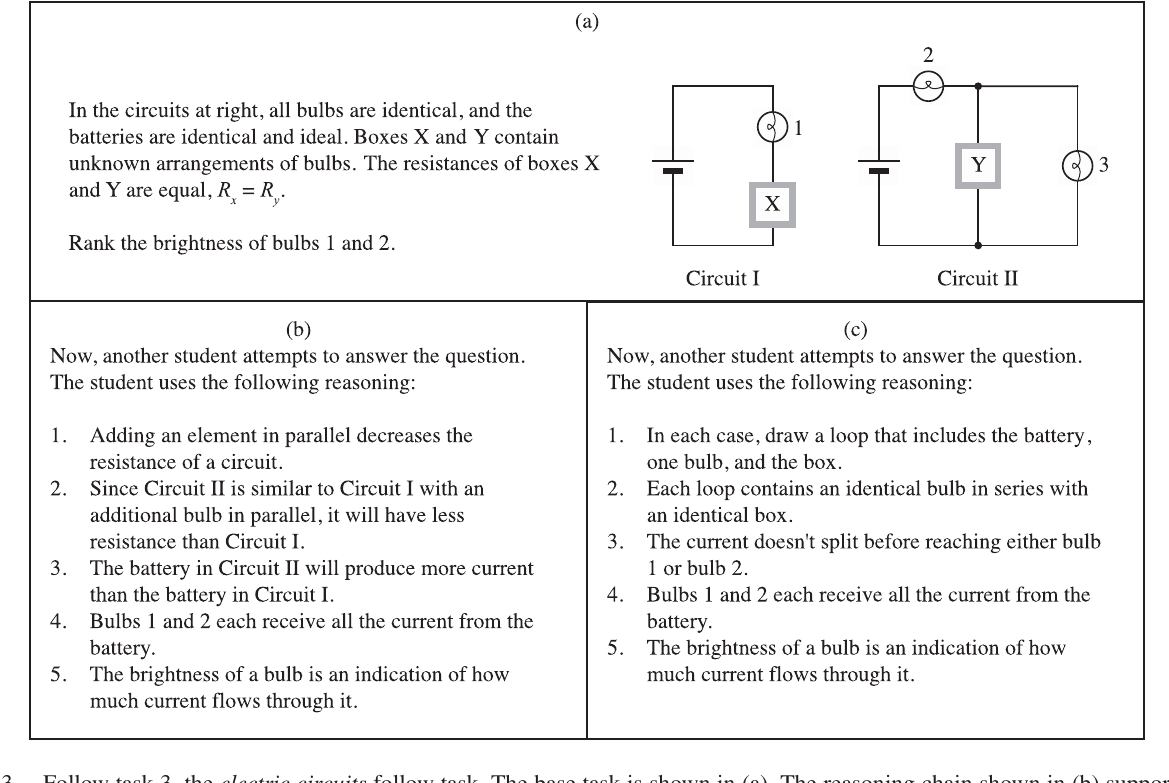
FIG. 3. Follow task 3, the electric circuits follow task. The base task is shown in (a). The reasoning chain shown in (b) supports the correct conclusion that bulb 2 will be brighter than bulb 1. The reasoning chain shown in (c) is incorrect and suggests that the two bulbs will be equally